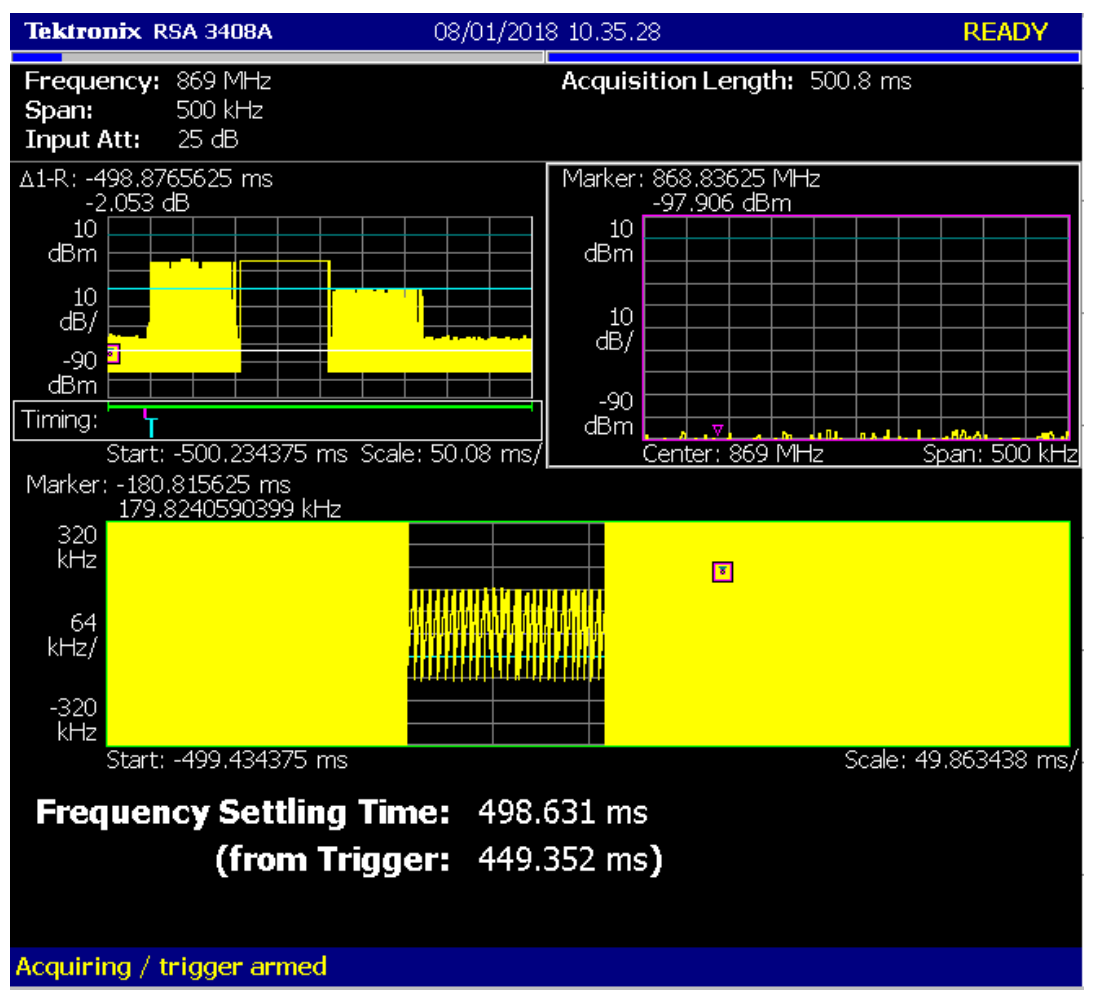
Figure 17. Time–frequency diagram of a LoRa packet with a duration of 103.42 ms. The acquired digital signals are reported in Figure